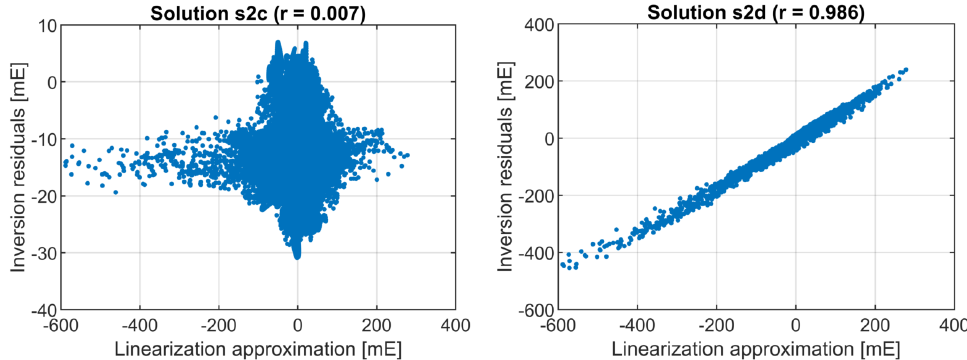
Figure 13. Linear correlation between the residuals of the inversion and the linearization approxima- tion in: solution using Equation (21) as is (s2c), and solution with the F rr ( · ) operator in place of the (cid:101) F rr ( · ) one into Equation (21)